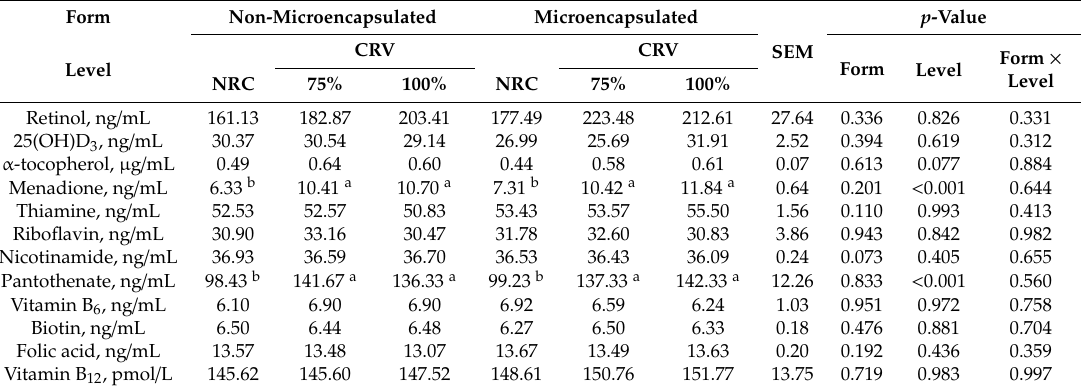
Table 7. E ff ects of vitamin forms and levels on plasma content of vitamins (d 14) 1 . Form Non-Microencapsulated Microencapsulated Level Retinol, ng / mL